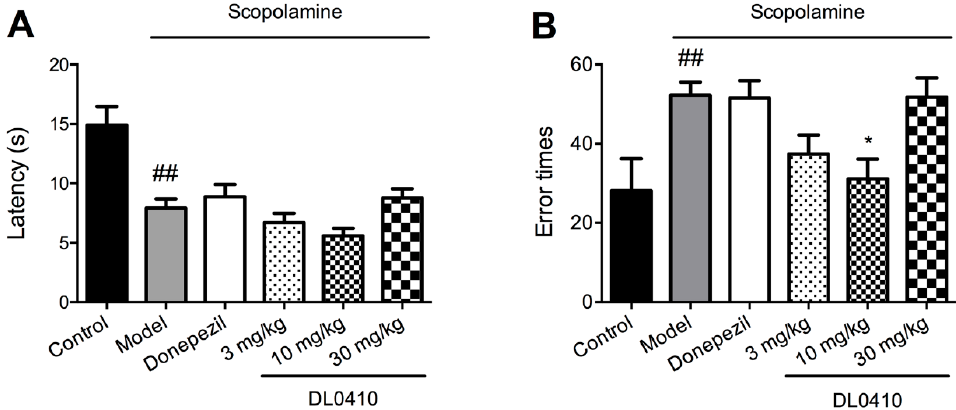
Figure 5. The effect of DL0410 on the passive avoidance task. Data were expressed as mean ± SEM ( n = 12). ( A ) The latency that mice took to firstly step into black chamber in the retention test. Scopolamine could induce mice to step into the black chamber with shorter latency, and donepezil and DL0410 showed the tendency to extend the latency; ( B ) The error times of mice stepping into black chamber in the retention test. Scopolamine could induce mice to step more times into the black chamber, and DL0410 could reduce the times of mice stepping into the black chamber. ## p < 0.01 vs. the control group; * p < 0.05 vs. the model group.